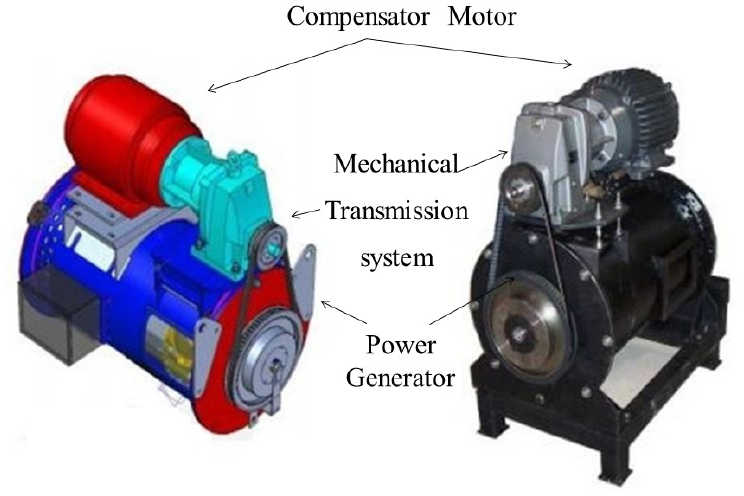
Figure 2. Architecture of the VSDG with rotating stator.